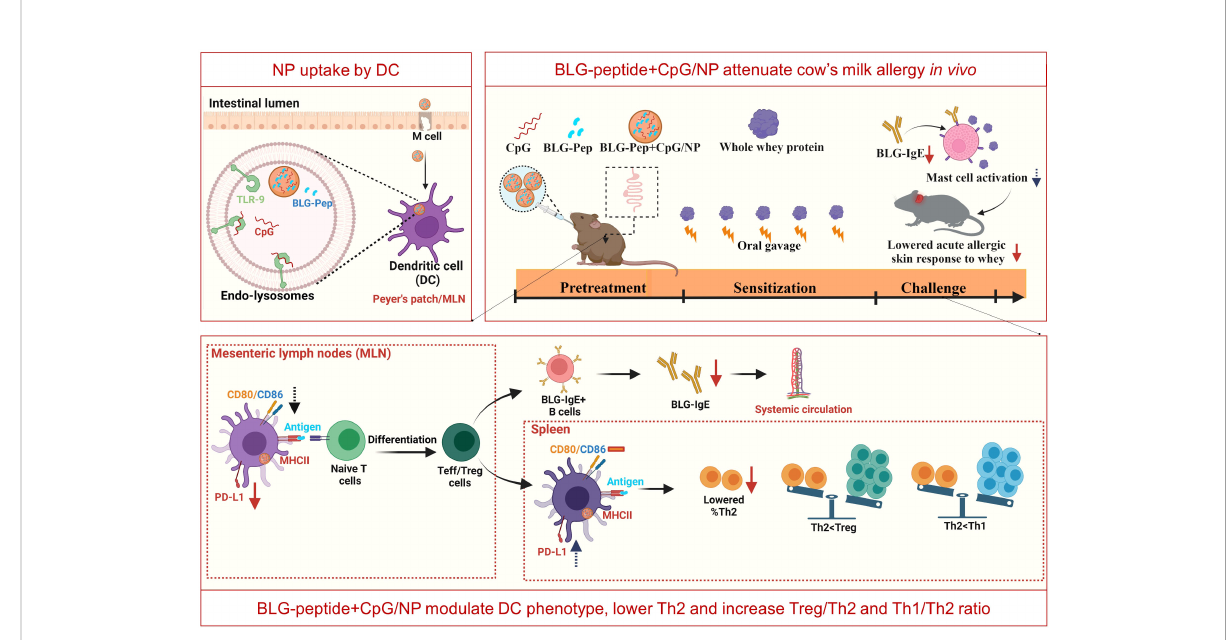
FIGURE 6 Graphical Abstract (Created with